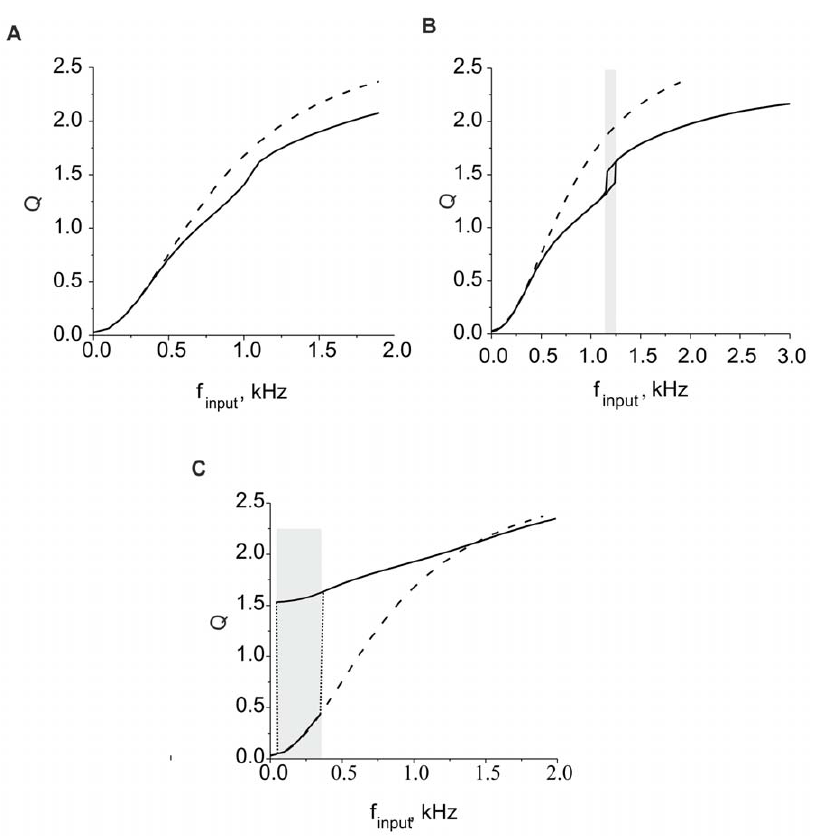
Figure 13. Steady state average activity depending on the frequency of synaptic input (solid curve). Dashed curve shows the activity curve without feedback. Parameter values: z 0 =p 0 =0, z 1 =p 1 =1, h z =1,k z =0.15, h p =1.5,k p =0.05, k q =0.01, a q =0.0001 msec 2 1 , b q =0.01 msec 2 1 , a z =0.001 msec 2 1 , b z =0.01 msec 2 1 , a p =0.001 msec 2 1 , b p =0.01 msec 2 1 , I 0 =4.5 m A/cm 2 , b 0 =6, k I =0.6625, and k b =0.4762. A. Monotonic regulation for low enough feedback gains, c Z =0.03 and c ZR =0.01 . B. Bistability for high input frequency, c Z =0.04 and c ZR =0.01 . C. Bistability for low input frequency, c Z =0.1 and c ZR =0.1 .